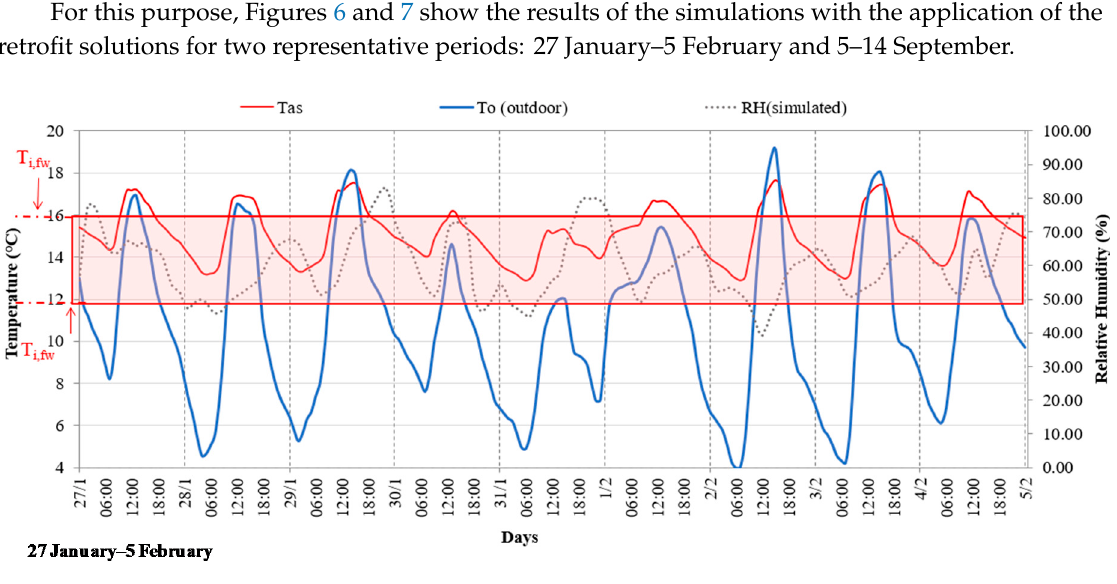
Figure 6. Daily profile of indoor air and operative temperature after retrofit of the building in free-running conditions during 27 January–5 February.